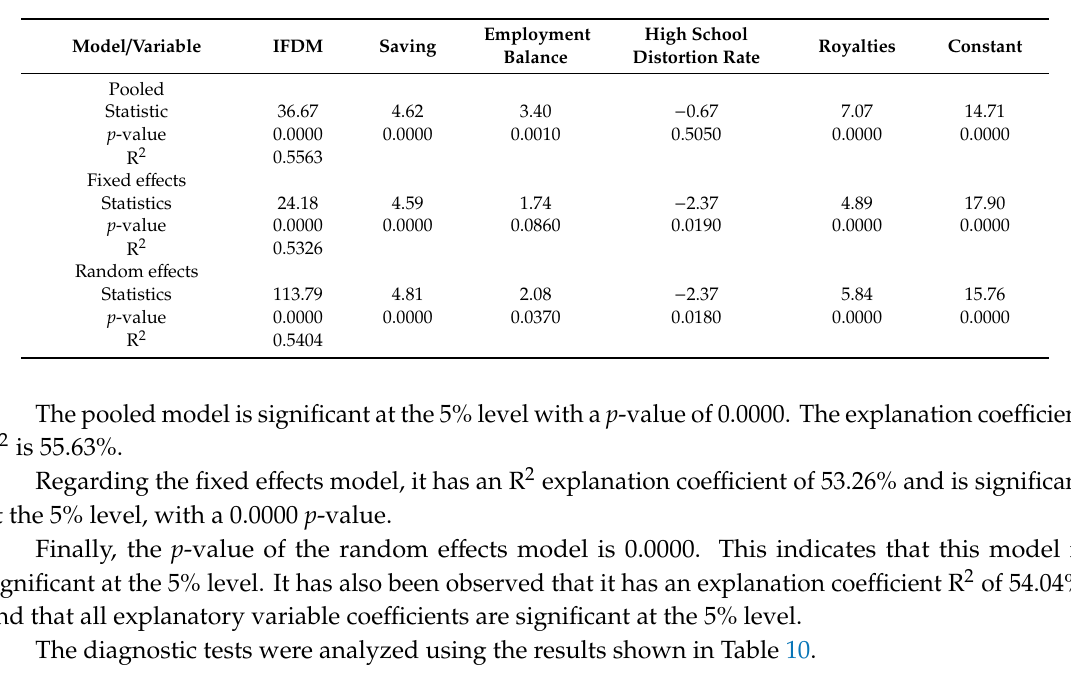
Table 9. Socioeconomic development model.